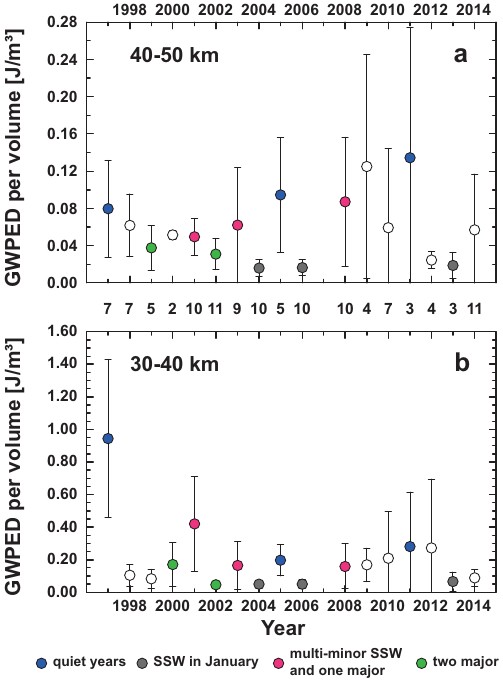
Figure 4. Monthly mean GWPED per volume and corresponding standard deviations during January measured between 40–50km (a) and 30–40km (b) , respectively. Numbers between the two plots re- fer to the number of available measurement days per year. The color coding marks the occurrence of stratospheric warmings as listed by Chandran et al.